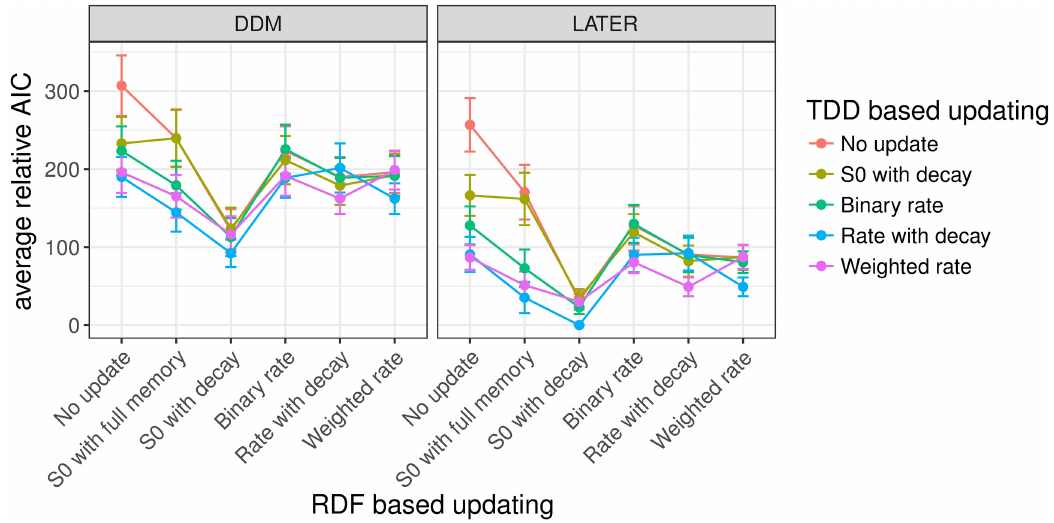
Fig 9. Mean relative AICs as a function of the tested models in Experiment 2. For each participant, the AIC of the best- performing model has been subtracted from the AIC for every model, before averaging across participants. Error bars indicate the standard error of the mean. The response-based updating rules are mapped onto the x-axis (RDF-based updating), while the dimension-based updating rules are indicated by different colors (TDD-based updating). The left-hand panel presents the results for the DDM, the right-hand panel for the LATER model. Only models with a non-decision time component are included in the figure. Models without a non-decision time component generally performed worse, and the best-fitting model included a non- decision time component (see also Table A in S4